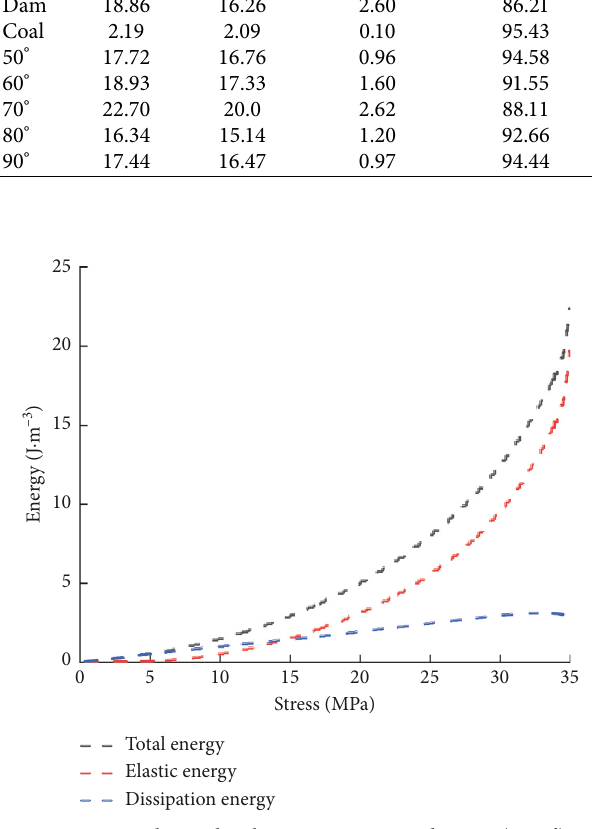
Figure 13: Relationship between energy and stress (A-70 ° ).